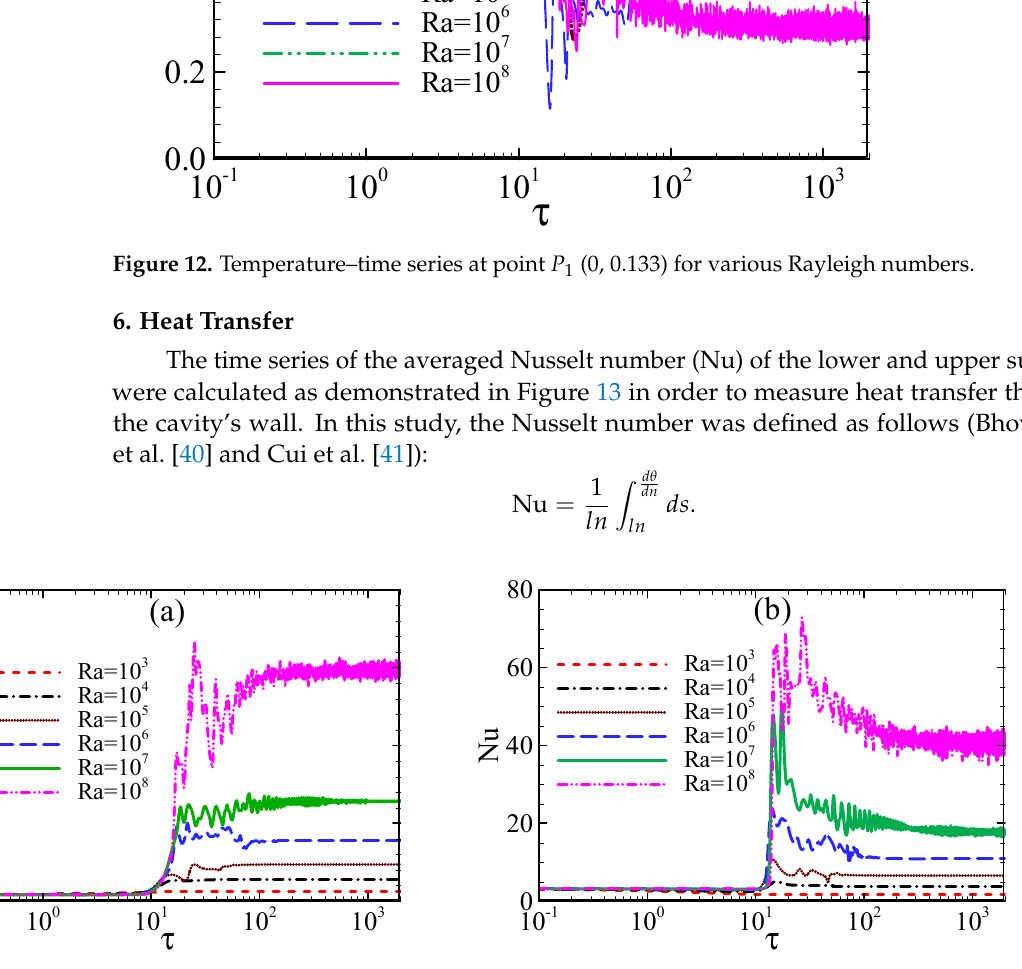
Figure 13. Time series of the Nusselt number for various Ra on ( a ) hot bottom wall and ( b ) cold top wall.